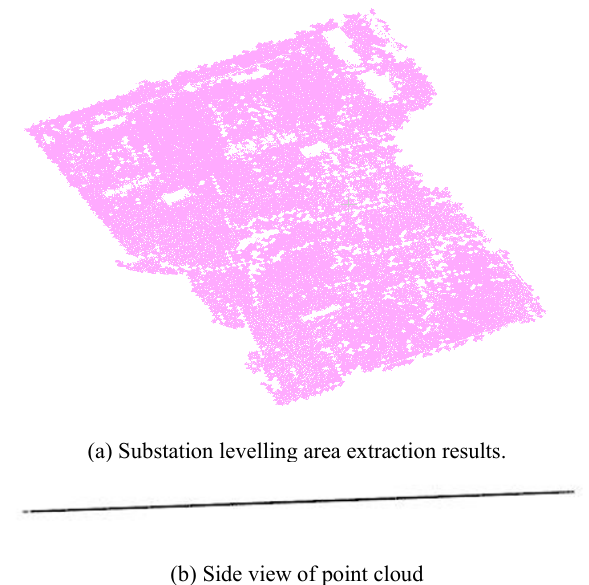
Figure 5. Extraction of the substation region from the point clouds. (a) shows that the normal constraint in vertical direction is a powerful way to filter out the non-equipment point clouds. The point clouds are rendered with height value, And the color consistent also shows that the assumption of substation levelling area. (b) demonstrates that the assumption is reasonable. The convex boundary of levelling area of substation is consistent with the equipment’s boundary